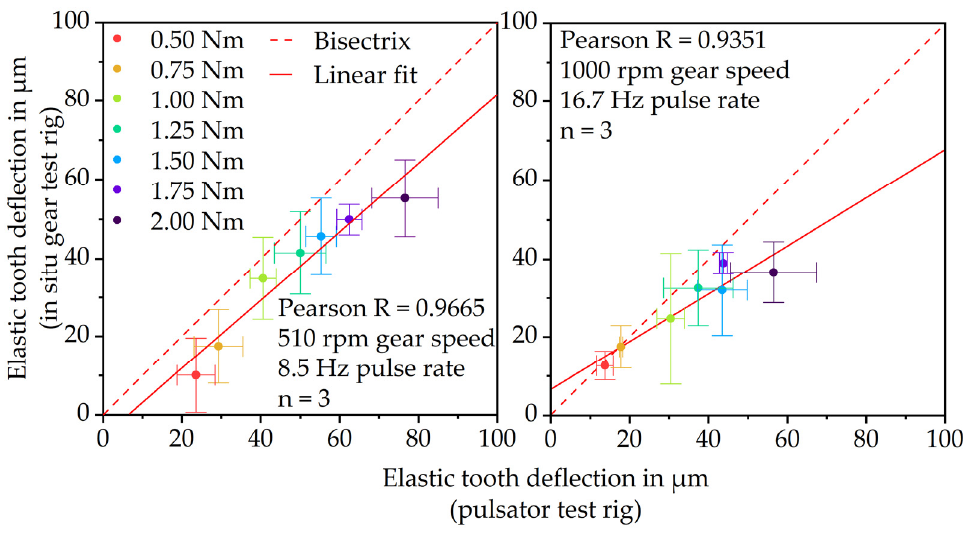
Figure 10. Offset adjusted correlation between in situ gear test rig and pulsator results for elastic tooth de fl ection.